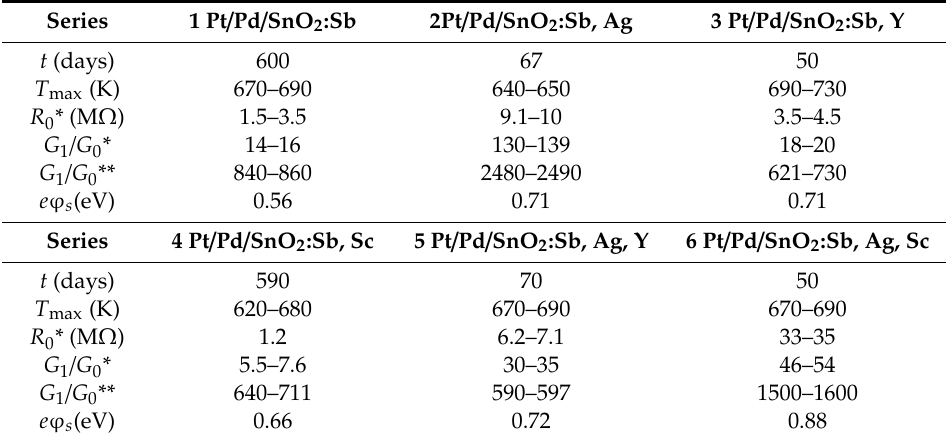
Table 3. The main parameters of the sensors of the di ff erent series after the completion of the tests. Series 1 Pt / Pd / SnO 2 :Sb 2Pt / Pd / SnO 2 :Sb,